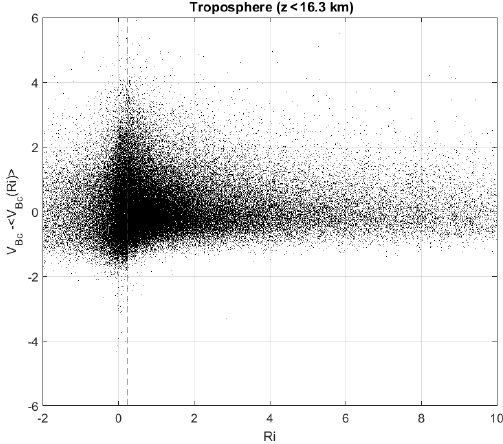
Figure 10. Same as Fig. 9a after removing the mean tendency shown by Fig. 9c for the troposphere. The vertical dashed line shows Ri c = 0 . 25.